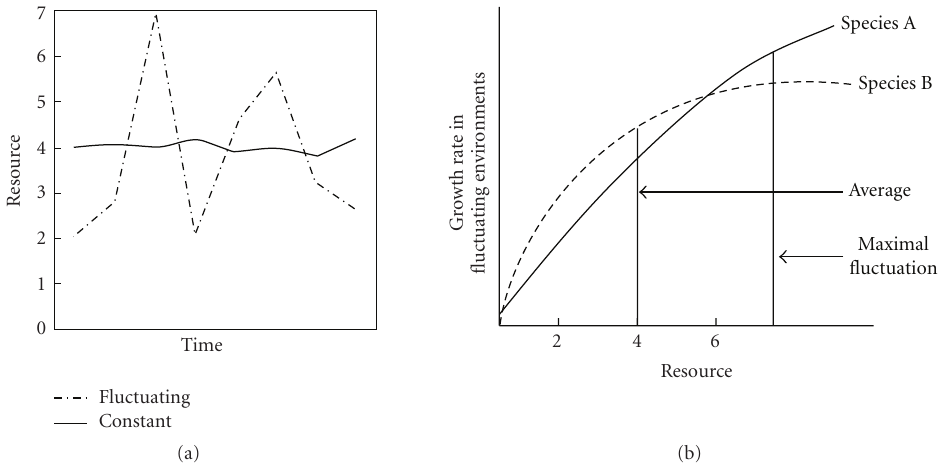
Figure 1: Fluctuation environments (a) allow alternate dominance (considered as growth rate) of di ff erent species A and B (b), while constant environments may lead to a permanent higher growth rate of a given species, allowing competitive exclusion. In the figure, constant resource availability around 4 (logarithm scaled) represents a permanent higher growth of species